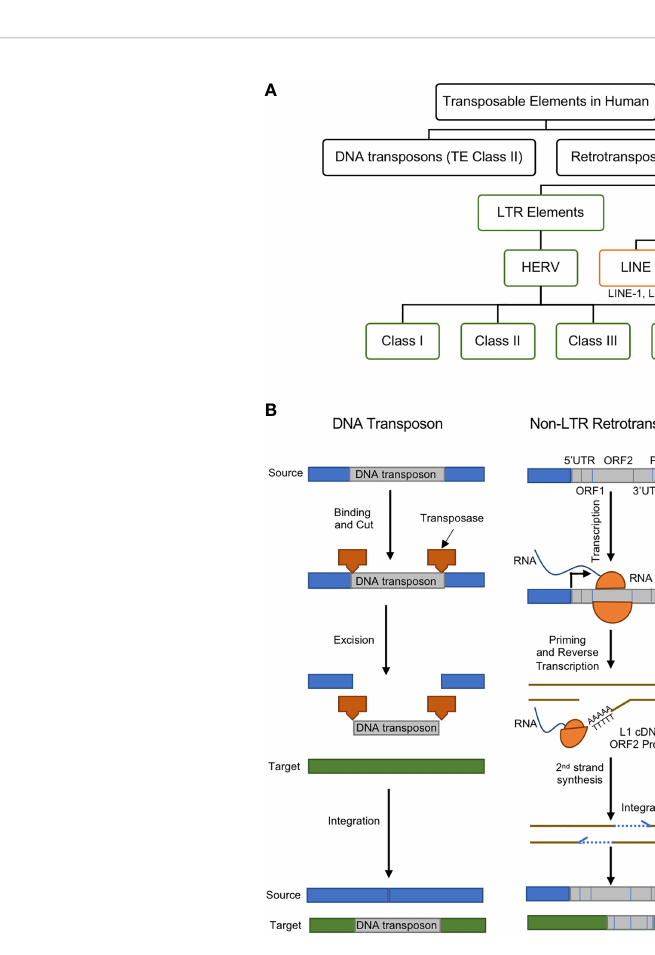
FIGURE 1 | (A) Classes and types of transposable elements (TEs) in the human genome, (B) gene regulatory mechanisms of DNA transposon (left), non-LTR retrotransposon (middle), and LTR retrotransposon (right). DNA transposons are mobilized through a cut and paste machinery that is based on a transposase that is encoded at their fl anked sequences. The transposase cuts the DNA transposon from the source and integrates it into a new genomic location. Retrotransposons require an intermediate step of the reverse transcription of an RNA to be mobilized. Non-LTR retrotransposons are transcribed to produce a full-length mRNA, but its transposition uses target-site primed reverse transcription (TPRT). This produces a single strand of cDNA, which is used to create the complementary strand of the ds-DNA that is integrated in the genomic DNA. This process can lead to target-site duplications (TSDs) and small deletions in the target. Non-LTR retrotransposons encode one or two open reading frames (ORFs). The retrotransposition of the LTR-retrotransposons require the encoding of the Gag protein, protease, reverse transcriptase, and integrase enzymes. The RNA polymerase II of the host recognizes the promoter of the LTR-retrotransposons and creates its mRNA. The Gag makes a virus-like particle that contains the mRNA, the reverse transcriptase and the integrase then uses them to create the full-length double-stranded DNA, which is later integrated into the host ’ s DNA using the integrase enzyme. Panel (B) was modi fi ed from